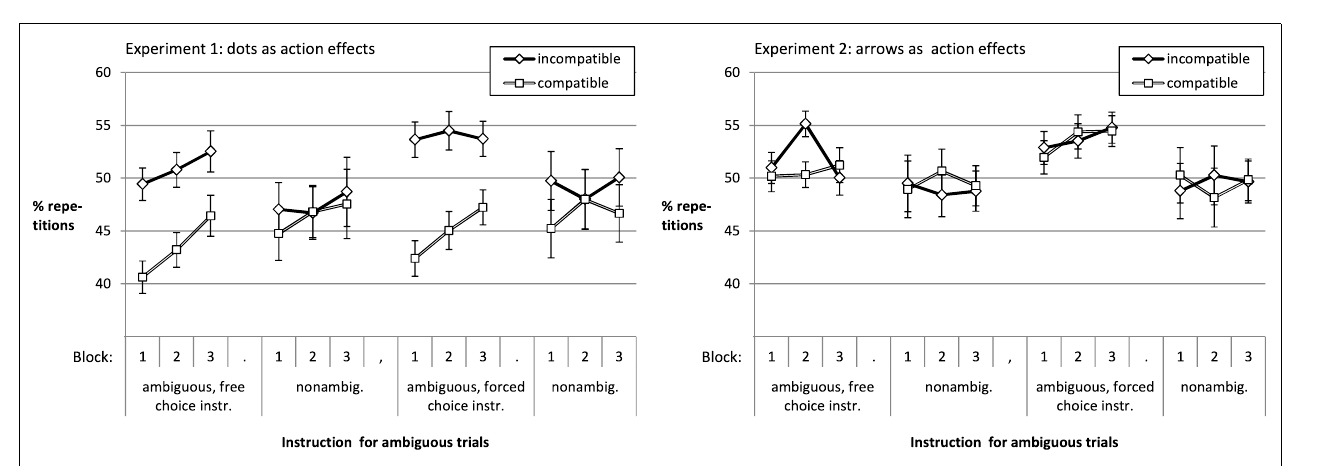
FIGURE 4 |Time course for proportion of response